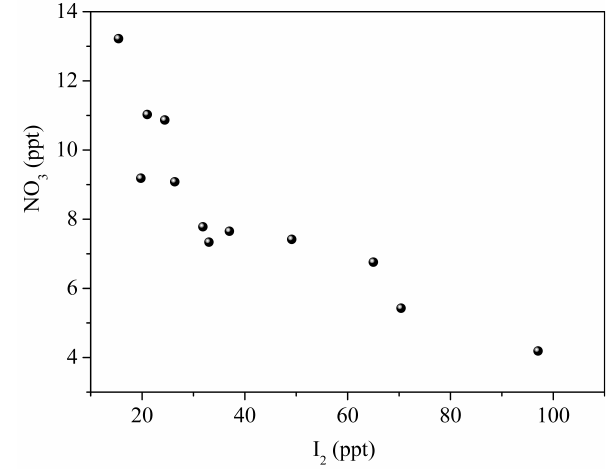
Fig. 6. Plot of O 3 versus I 2 during ozone destruction events at Mweenish Bay.